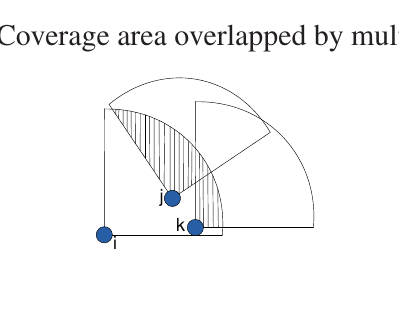
Figure 6. Coverage area overlapped by multiple